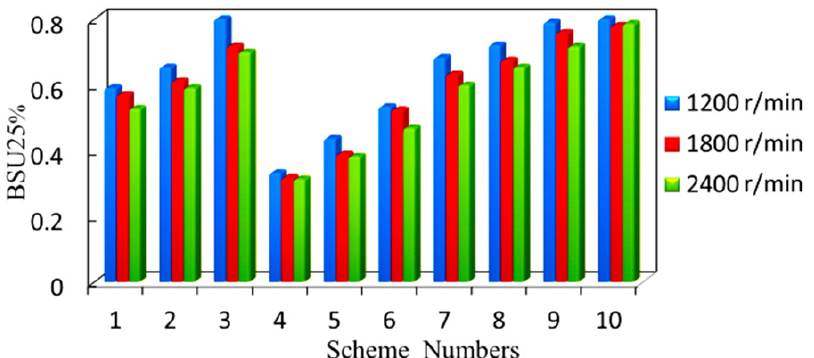
Figure 10. Smoke emissions of all swirl chamber diesel engine schemes with a 25% load. Note: the scheme numbers are the same as those in Table 1.